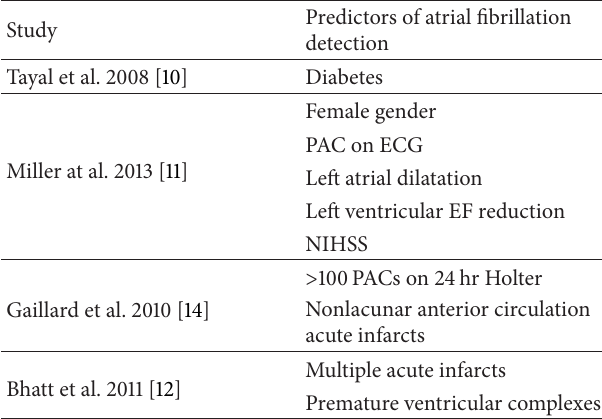
Table 2: Predictors of atrial fibrillation detection in patients with cryptogenic